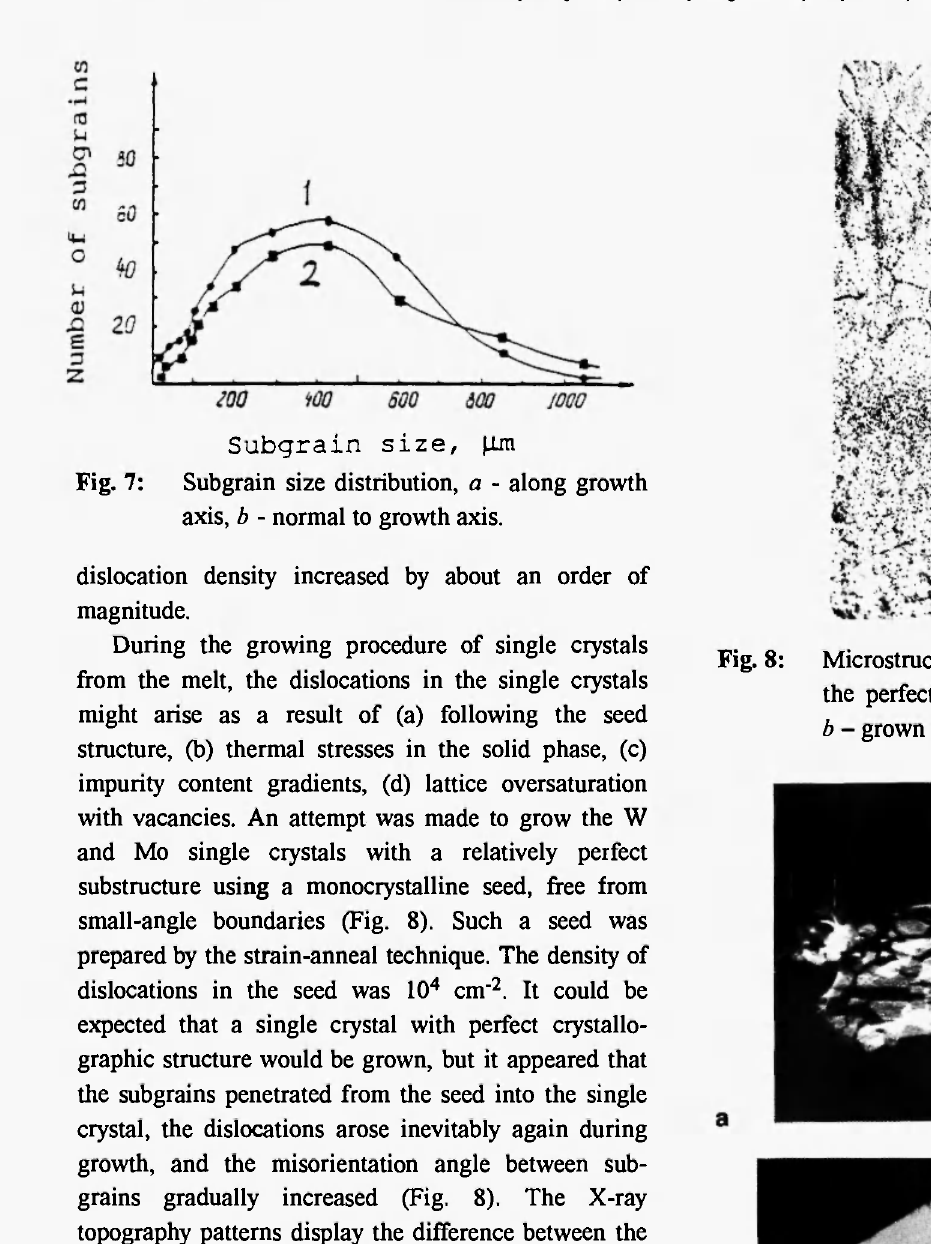
Fig. 8: Microstructure of W single crystal grown on the perfect monocrystalline seed, a - seed, b - grown single crystal.